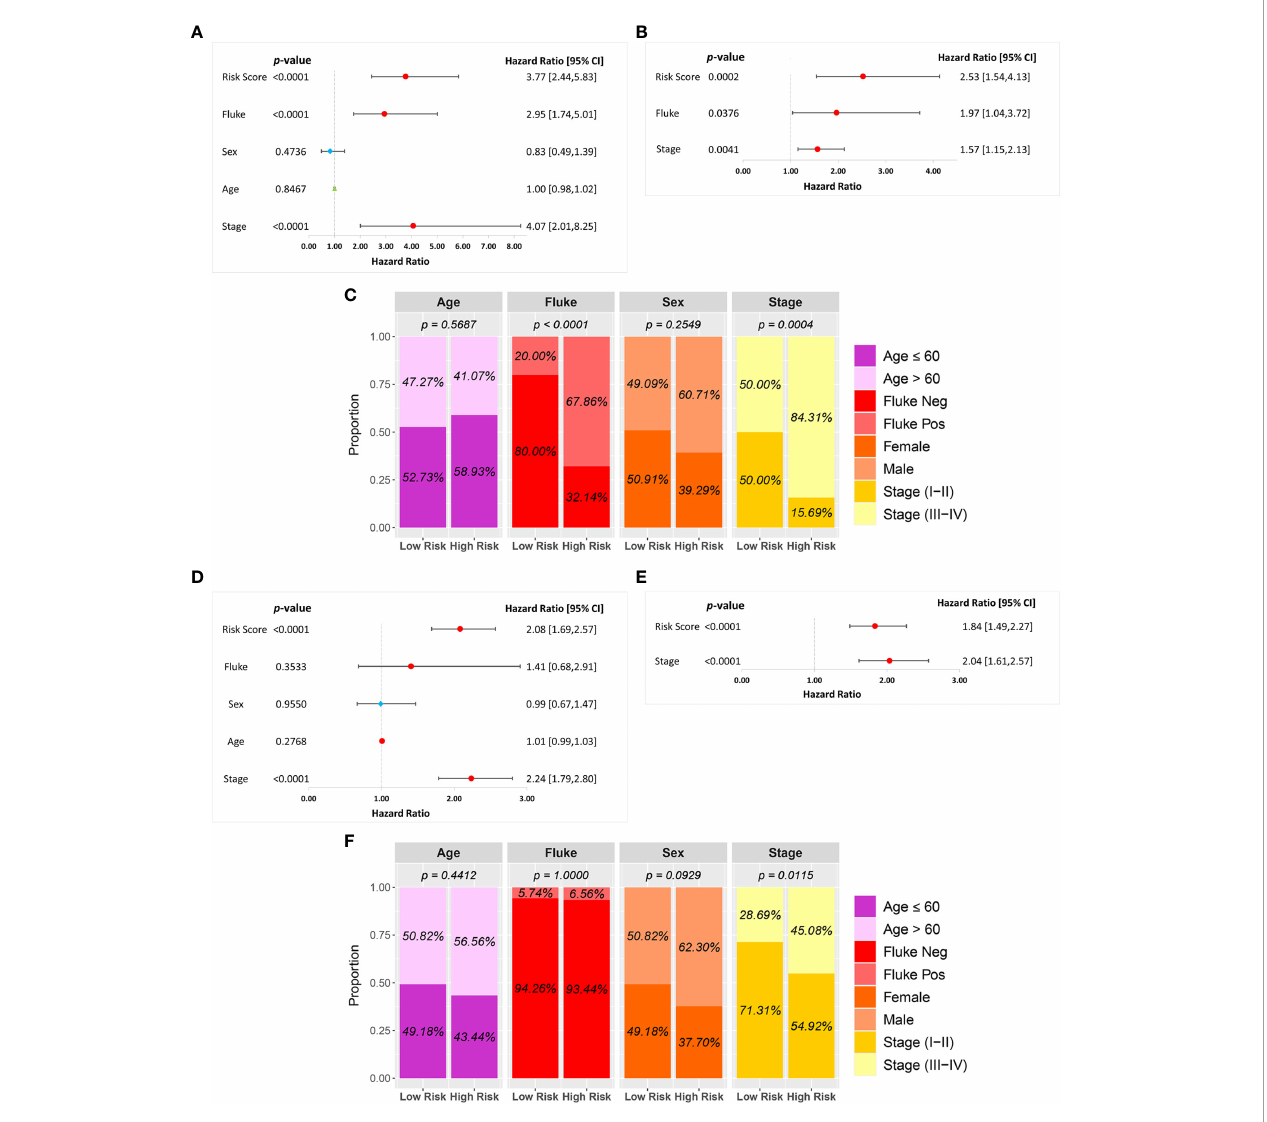
FIGURE 5 Univariate and multivariate Cox regression analyses of the six-FRG signature and other clinical characteristics in the (A – C) GSE89749 and (D – F) OEP00105